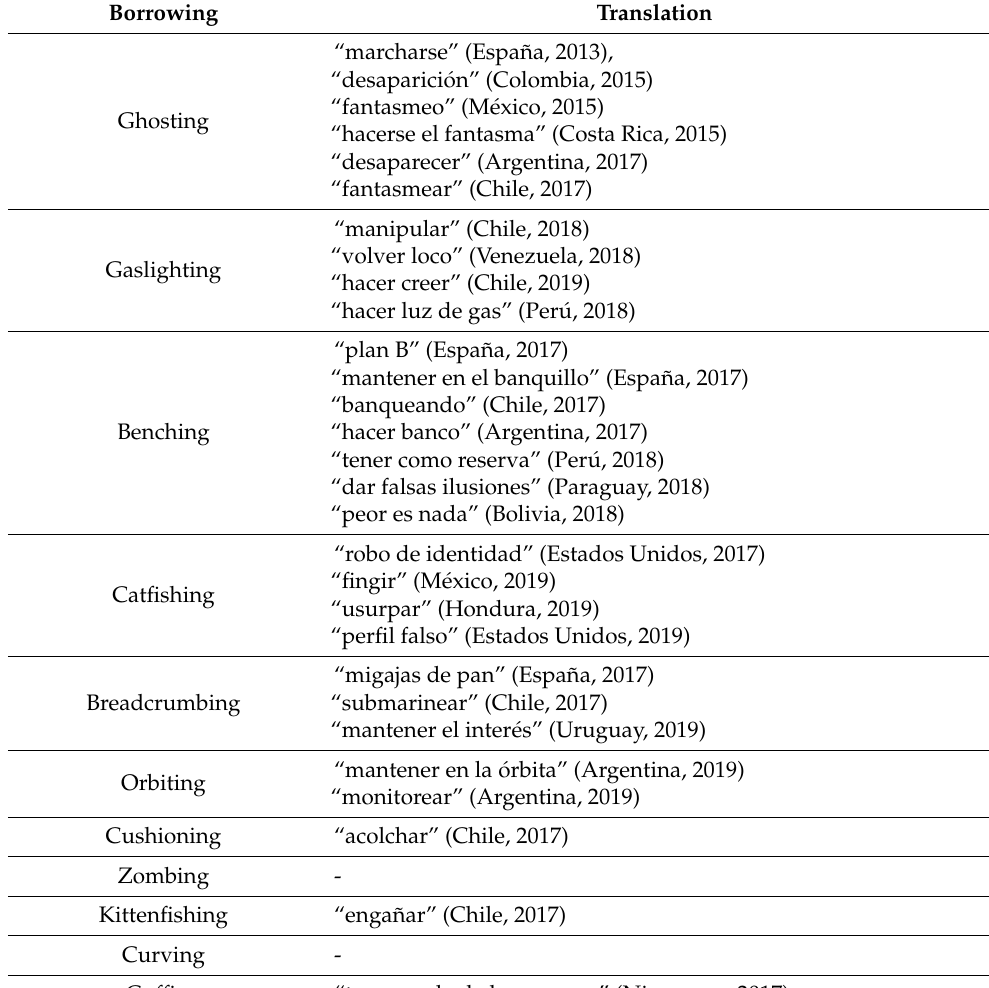
Table 4. Spanish equivalents included in the publications of the Corpus NOW (News on the